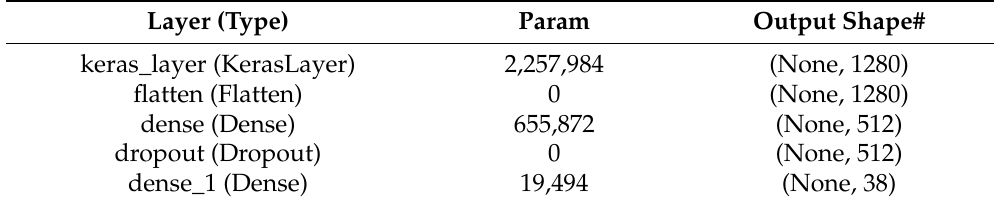
Table 1. Main characteristics of the employed